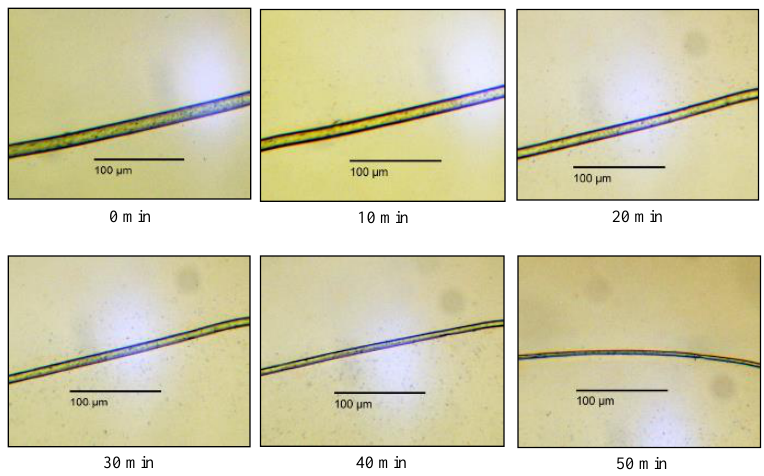
Figure 5. Dissolution of PA 6.6 fibre in dissolving solvent (DISS).